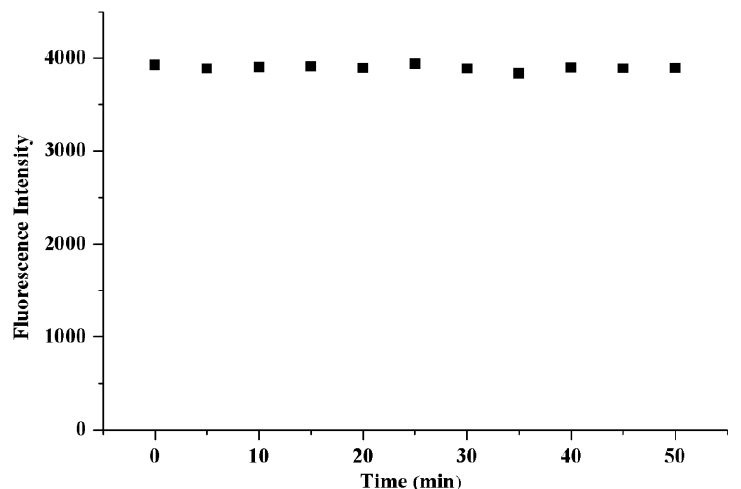
Figure 2. Fluorescence stability of the MIP in PBS